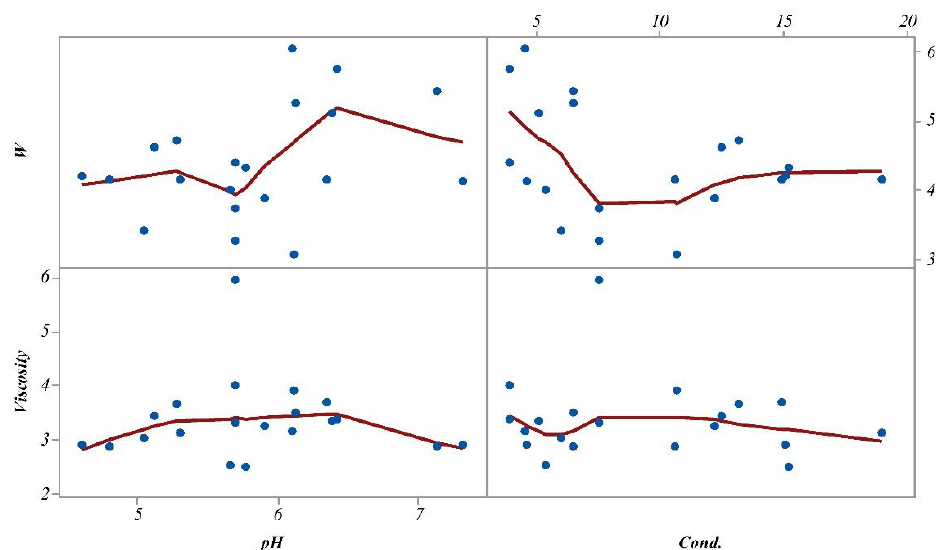
Fig. 10. Matrix plots of deposition weight (g) and viscosity (mPa.s) vs. pH and conductivity (µS.cm -1